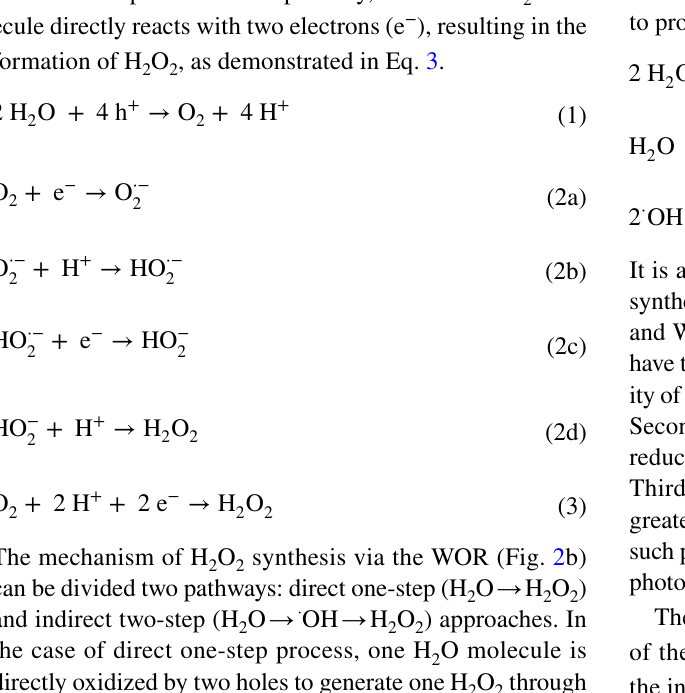
Fig. 2 Simplified schematic of photocatalytic H 2 O 2 generation from a ORR, b WOR and c dual-channel pathway. Simplified schematic of elec- trocatalytic H 2 O 2 production from d ORR, e WOR and f dual-channel